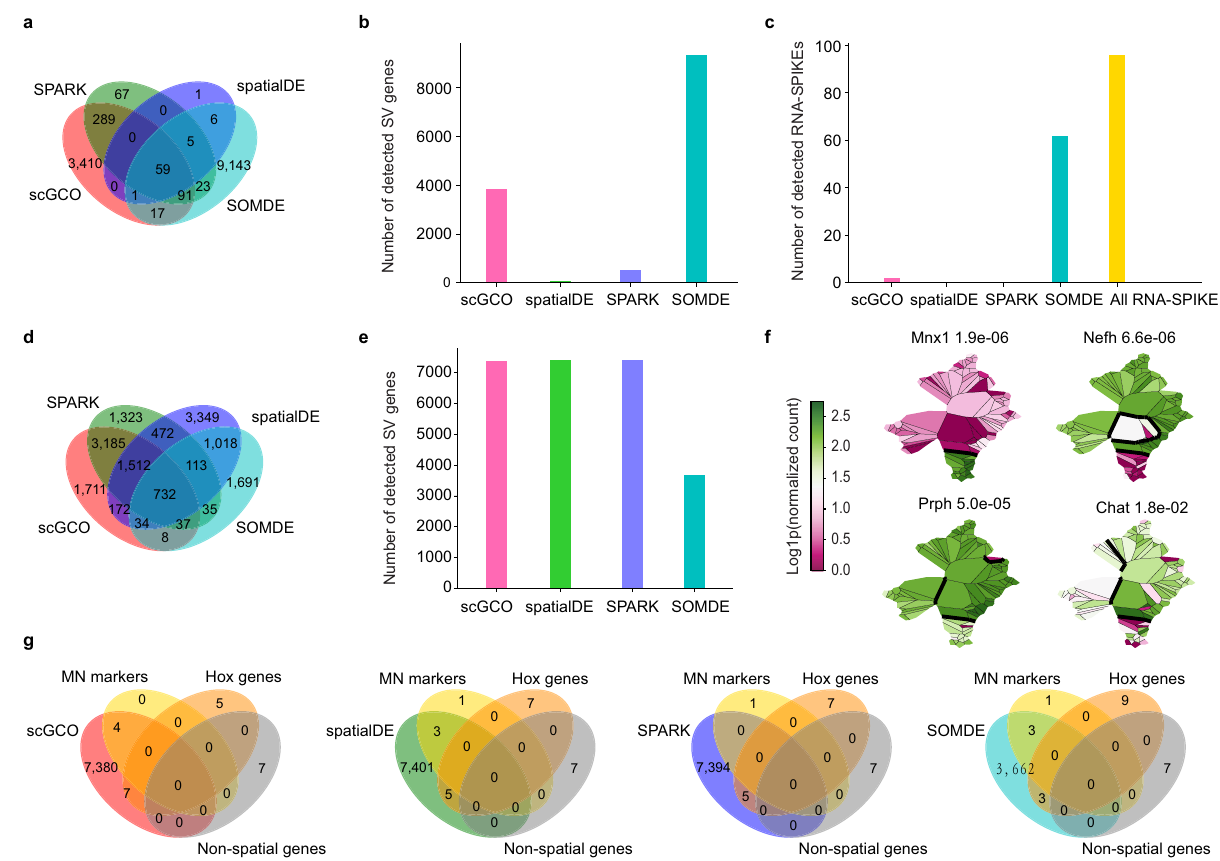
Fig. 6 | Analyses of SV gene identi fi cation algorithms with mouse neuron tis- sues data generated with LCM-seq technology. a , b Venn diagram and bar plot showing the overlapand number of SVgenes identi fi ed bydifferent methods from mouse medial ganglionic eminence (MGE). (c) Bar plot showing the number of detected RNA SPIKEs (designed as negative controls) by different methods. d , e Venn diagram and bar plot showing the overlap and number of SV genes identi fi ed by different methods from mouse motorneurons (MNs) tissues. f Graph